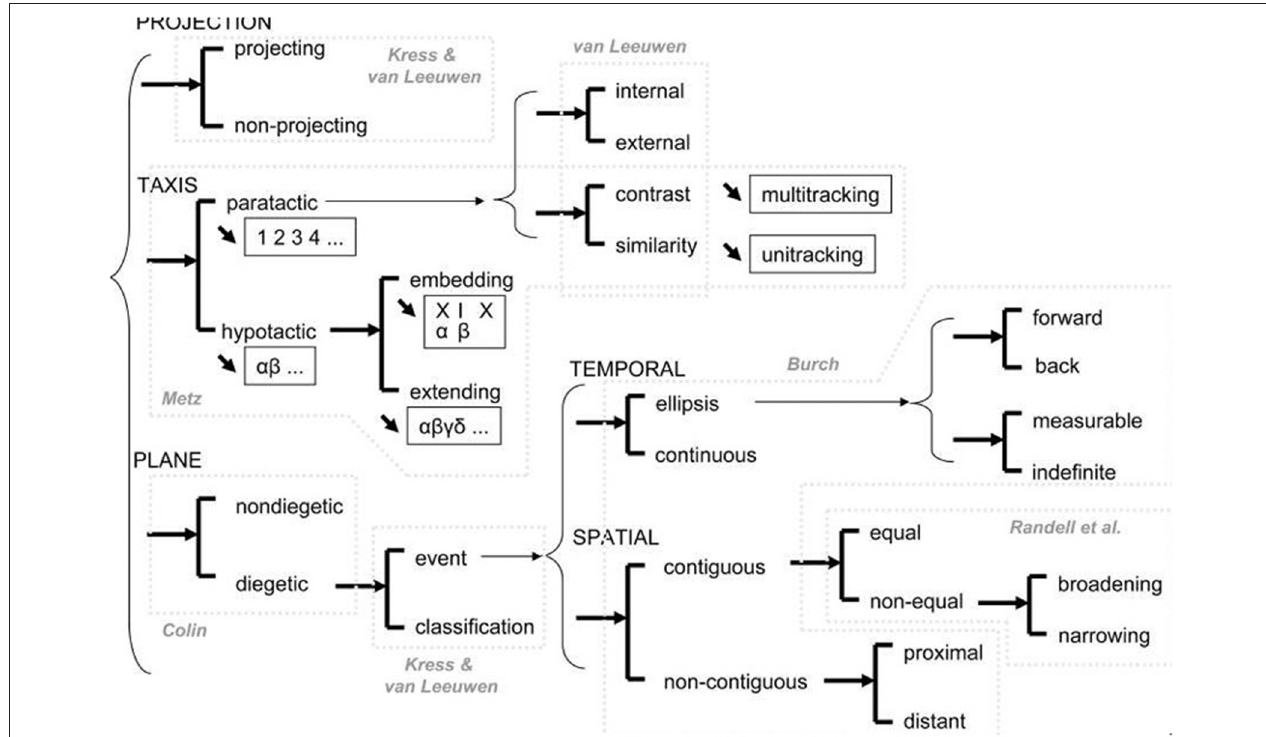
FIGURE 1 | The grande paradigmatique developed by Bateman